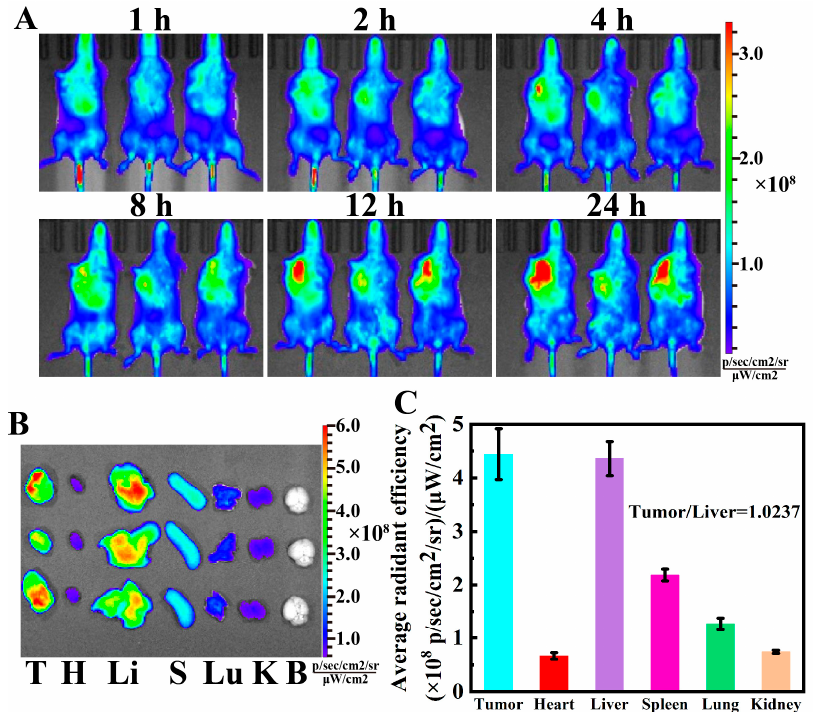
Figure 6. In vivo biodistribution of ASSO-NPs in 4T1 tumor-bearing mice. ( A ) Dynamic biodistribution of ASSO-NPs at different times. ( B ) Biodistribution of ASSO-NPs in isolated organs 24 h after administration, T: tumor, H: heart, Li: liver, S: spleen, Lu: lung, K: kidney, B: brain. ( C ) Fluorescence intensity at different organs was calculated. Data represent mean ± SD ( n = 3).